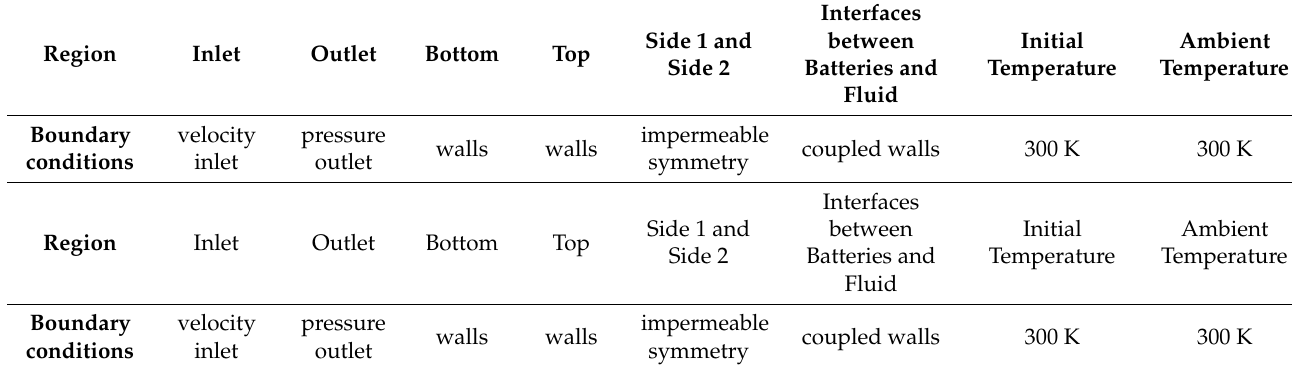
Table 2. Boundary condition settings.